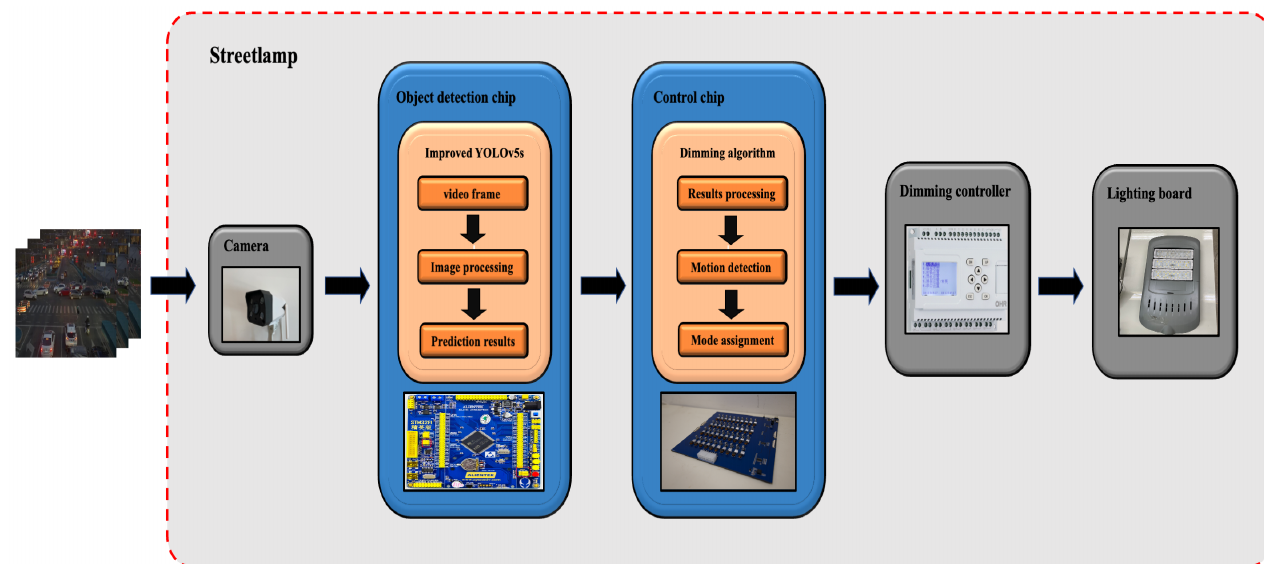
Figure 2. The structure of the proposed